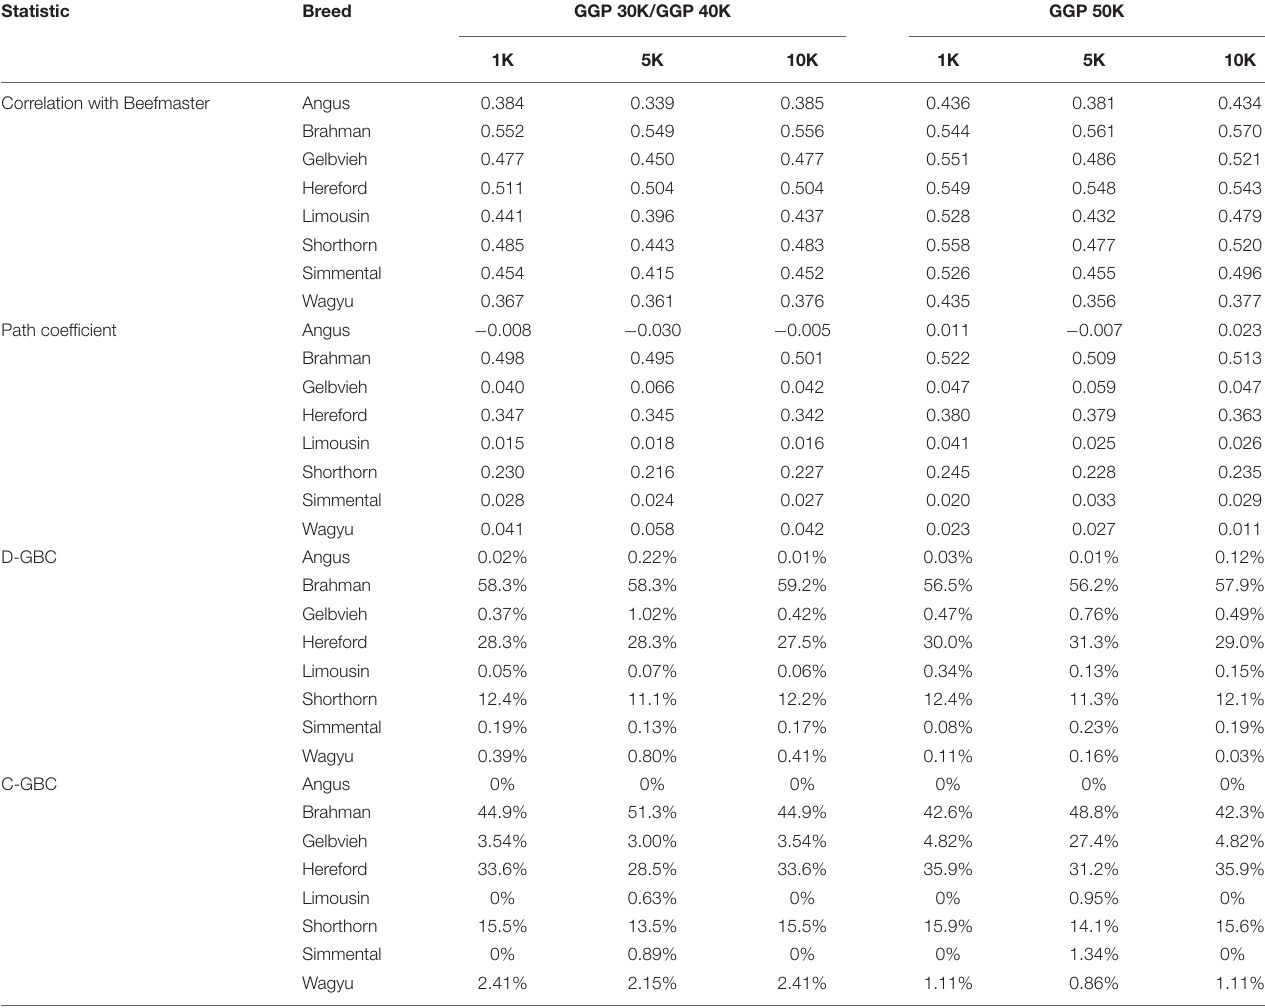
TABLE 5 | Path analysis using the correlation data for 7,605 Beefmaster animals with eight reference breeds and three SNP panels (1K, 5K, and 10K). Statistic Breed